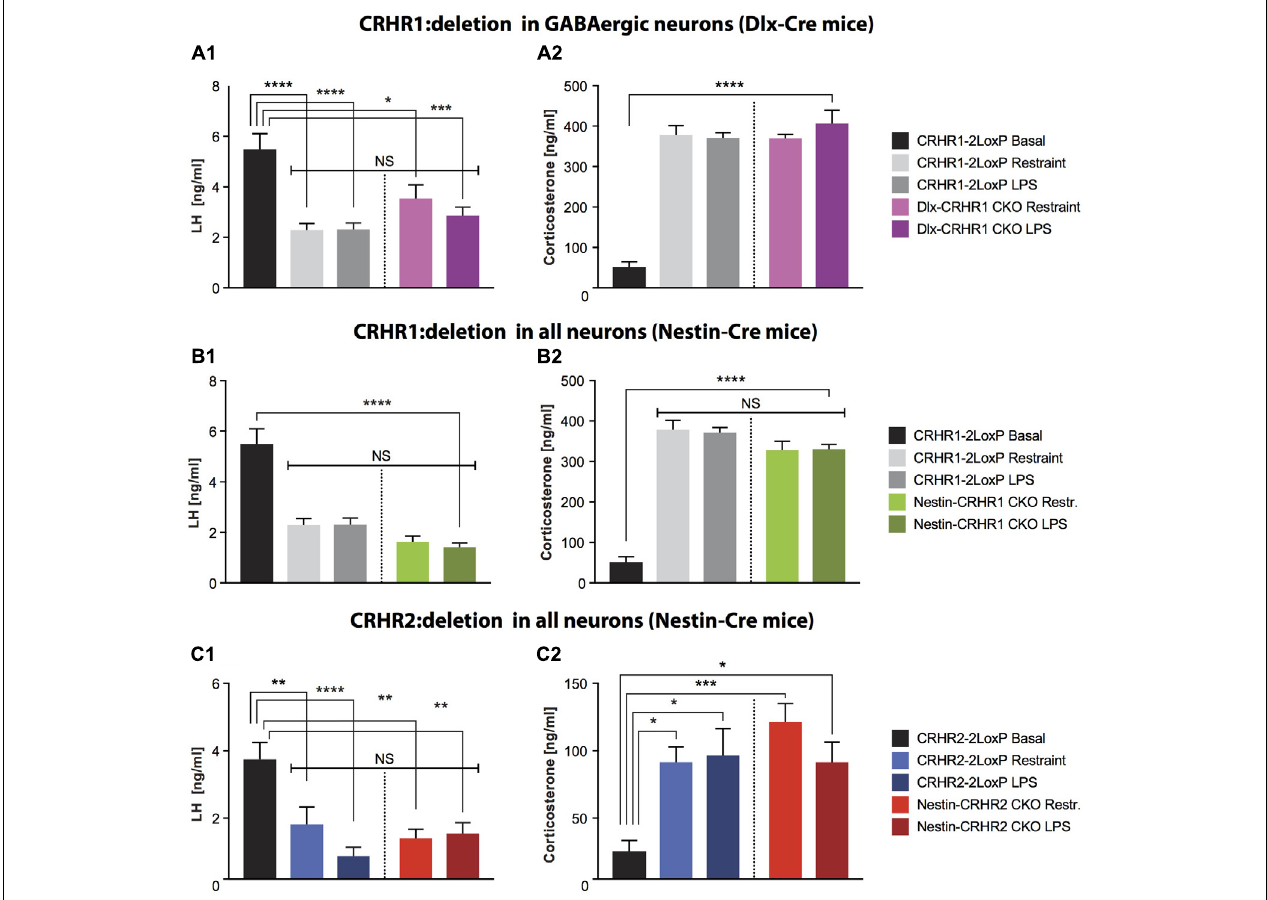
FIGURE 4 | LH and CS concentrations in mice lacking CRHR1 in GABAergic neurons (Dlx-CRHR1 CKO mice) or in mice lacking CRHR1 or CRHR2 in all neurons (Nestin-Cre lines), subjected to restraint stress or LPS injection. (A1) Restraint stress ( n = 5) and LPS ( n = 8) decreased LH concentration in Dlx-CRHR1 CKO mice compared to non-stressed CRHR1-LoxP mice ( n = 8). Stress-induced LH levels of control mice [CRHR1-2LoxP mice: Restraint ( n = 12) and LPS ( n = 12)] were similar to LH levels of the respective stressed Dlx-CRHR1 CKO mice, NS, p > 0.05 in all cases. One-way ANOVA, F (4, 40) = 14.23, p < 0.0001, followed by Tukey’s multiple comparisons test CRHR1-2LoxP Basal vs. CRHR1-2LoxP Restraint, ∗∗∗∗ p < 0.0001, CRHR1-2LoxP Basal vs. CRHR1-2LoxP LPS, ∗∗∗∗ p < 0.0001, CRHR1-2LoxP Basal vs. Dlx-CRHR1 CKO Restraint, ∗ p = 0.0174 and CRHR1-2LoxP Basal vs. Dlx-CRHR1 CKO LPS, ∗∗∗ p = 0.0001. (A2) Restraint stress or LPS lead to equally increased CS levels in stressed animals of all groups. One-way ANOVA, F (4, 40) = 50.81, p < 0.0001, followed by Tukey’s multiple comparisons (CRHR1-2LoxP Basal vs. CRHR1-2LoxP Restraint, CRHR1-2LoxP Basal vs. CRHR1-2LoxP LPS, CRHR1-2LoxP Basal vs. Dlx-CRHR1 CKO Restraint and CRHR1-2LoxP Basal vs. Dlx-CRHR1 CKO LPS, ∗∗∗∗ p < 0.0001 in all cases). (B1) Restraint stress and LPS induced a significant reduction in plasma LH levels in both controls (CRHR1-LoxP; Restraint, n = 12; LPS, n = 12) and Nestin-CRHR1 CKO mice (Restraint, n = 12; LPS, n = 12) compared to untreated CRHR1-2LoxP mice ( n = 8). One-way ANOVA F (4, 48) = 28,38, p < 0.0001, followed by Tukey’s multiple comparisons test, CRHR1-2LoxP Basal vs. CRHR1-2LoxP Restraint, ∗∗∗∗ p < 0.0001, CRHR1-2LoxP Basal vs. CRHR1-2LoxP LPS, ∗∗∗∗ p < 0.0001, CRHR1-2LoxP Basal vs. Nestin-CRHR1 CKO Restraint, ∗∗∗∗ p < 0.0001 and CRHR1-2LoxP Basal vs. Nestin-CRHR1 CKO LPS, ∗∗∗∗ p < 0.0001. No significant differences were observed between the LH levels of stressed Nestin-CRHR1 CKO and those of stressed control mice (NS, p > 0.05 in all cases). (B2) Exposure to stress (either Restraint or LPS) resulted in a significant increase in plasma CS levels in both controls (CRHR1-2LoxP; Restraint, n = 12; LPS, n = 12) and Nestin-CRHR1 CKO mice (Restraint, n = 12; LPS, n = 12) compared to untreated CRHR1-2LoxP mice ( n = 8). One-way ANOVA F (4, 48) = 53,75, p < 0.0001, followed by Tukey’s multiple comparisons tests CRHR1-2LoxP Basal vs. CRHR1-2LoxP Restraint, CRHR1-2LoxP Basal vs. CRHR1-2LoxP LPS, CRHR1-2LoxP Basal vs. Nestin-CRHR1 CKO Restraint, and CRHR1-2LoxP Basal vs. Nestin-CRHR1 CKO LPS, ∗∗∗∗ p < 0.0001 in all cases. No significant differences were observed between the CS levels of stressed Nestin-CRHR1 CKO and those of stressed control mice (NS, p > 0.05 in all cases). (C1) Restraint stress and LPS led to a significant decrease in plasma LH levels in both controls (CRHR2-2LoxP; Restraint, n = 9; LPS, n = 9) and Nestin-CRHR2 CKO mice (Restraint, n = 9; LPS, n = 8) when compared to untreated CRHR2-2LoxP mice ( n = 6). One-way ANOVA, F (4, 36) = 7.559, p = 0.0002, followed by Tukey’s multiple comparisons tests; CRHR2-2LoxP Basal vs. CRHR2-2LoxP Restraint, ∗∗ p = 0.0088, CRHR2-2LoxP Basal vs. CRHR2-2LoxP LPS, ∗∗∗∗ p < 0.0001, CRHR2-2LoxP Basal vs. Nestin-CRHR2 CKO Restraint ∗∗ p = 0.0011, and CRHR2-2LoxP Basal vs. Nestin-CRHR2 CKO LPS, ∗∗ p = 0.0030. No significant differences were observed between the LH levels of stressed Nestin-CRHR2 CKO and those of stressed control mice (NS, p > 0.05 in all cases). (C2) After restraint stress or LPS, the plasma concentration of CS was significantly increased in both control stressed mice (CRHR2-2LoxP; Restraint, n = 9; LPS, n = 9) and Nestin-CRHR2 CKO mice (Restraint, n = 9; LPS, n = 8) when compared to untreated CRHR2-2LoxP mice ( n = 6). One-way ANOVA, F (4, 36) = 5.075, p = 0.0024, followed by Tukey’s multiple comparisons tests, CRHR2-2LoxP Basal vs. CRHR2-2LoxP Restraint, ∗ p = 0.0326, CRHR2-2LoxP Basal vs. CRHR2-2LoxP LPS, ∗ p = 0.0182, CRHR2-2LoxP Basal vs. Nestin-CRHR2 CKO Restraint ∗∗∗ p = 0.0008 and CRHR2-2LoxP Basal vs. Nestin-CRHR2 CKO LPS, ∗ p = 0.0388. No significant differences were observed between the CS levels of stressed Nestin-CRHR2 CKO and those of stressed control mice (NS, p > 0.05 in all